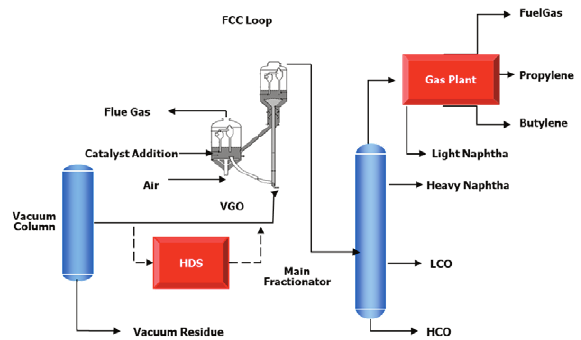
Figure 4. FCC Reactor and Fractionation